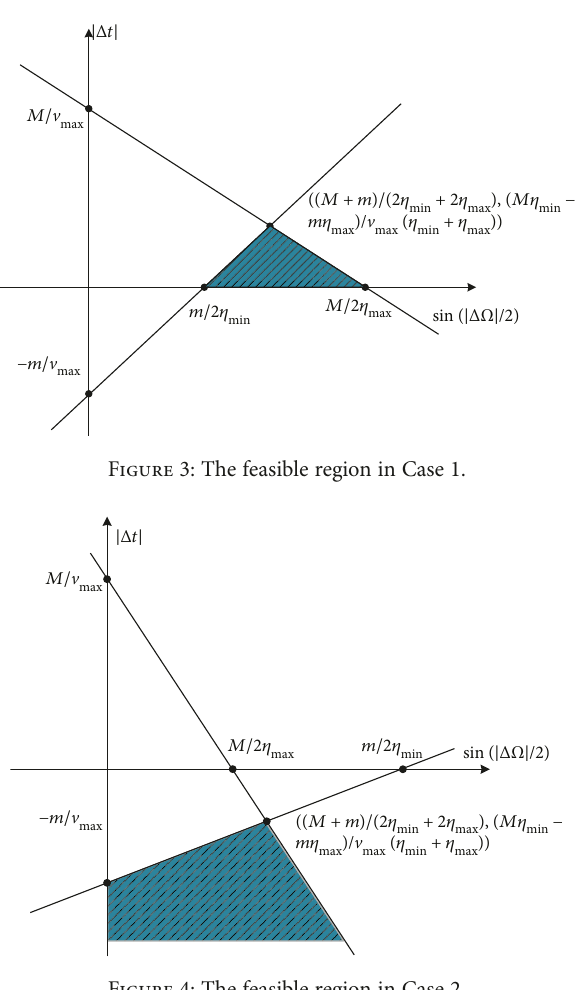
Figure 4: The feasible region in Case